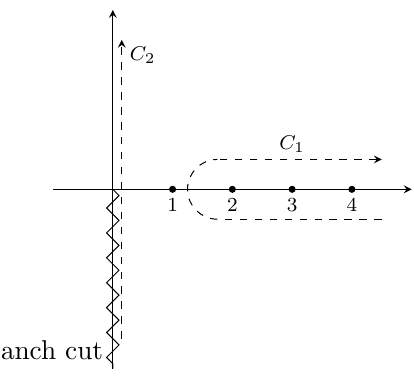
Figure 9 . Contour deformation C 1 ! C 2 . The branch cut (zigzag line) arises from the x (cid:0) 3 = 2 term in the integrand (A.4) should also be deformed to the left half plane Re x 6 0, such that the integrand is analytic on the right half Re x > 0 except the poles at discrete integer points x = 1 ; 2 ; 3 ; : : :